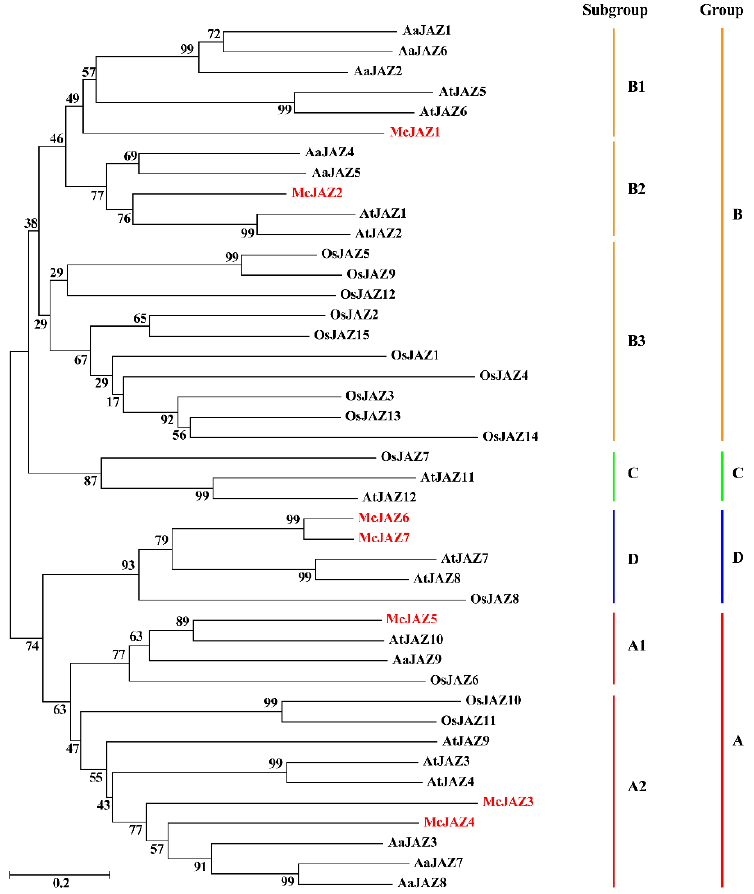
Figure 3. Phylogenetic analysis of JAZ proteins from M. canadensis and other species. JAZ amino acid sequences from M. canadensis were aligned with those from A. thaliana (eudicot), O. sativa (monocot) and A. annua (eudicot) using Clustal X2, and a neighbor-joining (NJ) phylogenetic tree was constructed using MEGA5.1. Bootstrap values indicate the percentage among 2000 replicates. JAZ